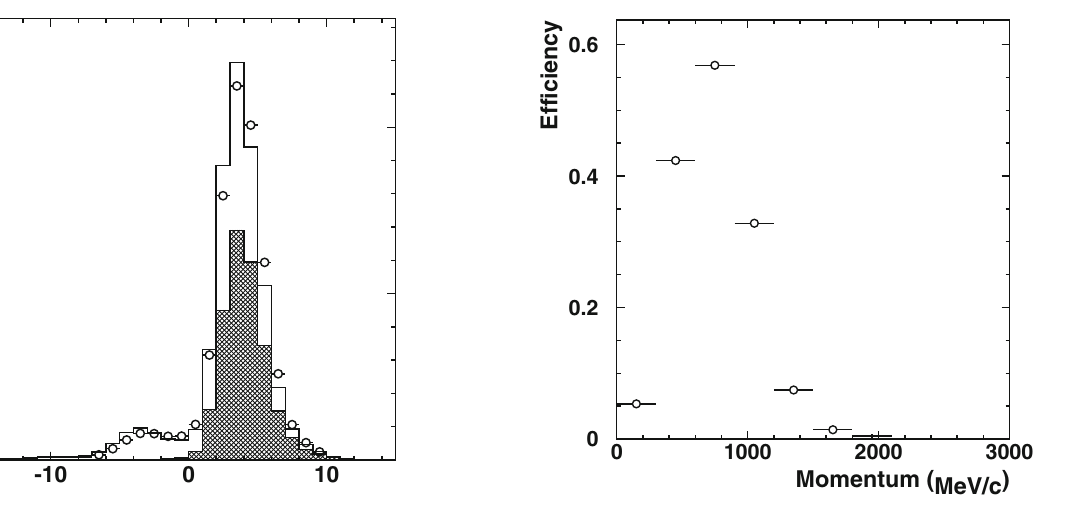
Fig. 24 Relative selection efficiency of FC1R μ to all events in the fiducial volume as a function of